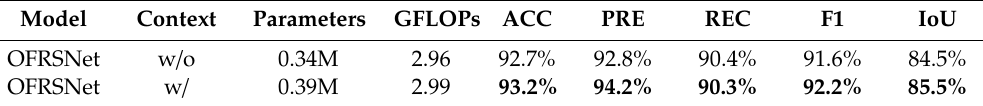
Table 4. Performance comparison of the model with and without context.